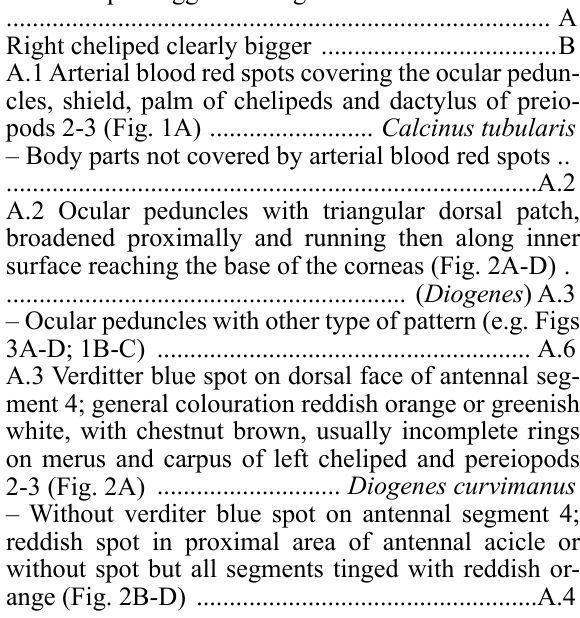
Eyes (Fig. 14C.1). Velvet black reduced corneas; ocular peduncles peach blossom red. Antennules (Fig. 14C.2) hyaline Berlin blue with wood brown ring on proximal margin of segments 2-3. Antennae (Fig. 14C.3) peach blossom red with some darker areas. Shield (Fig. 14C.4) deep peach blossom red, darker on frontal margin. Chelipeds. Right (Fig. 14C.5-6) with rose red background fading distally, and scattered wood brown stains. Left (Fig. 14C.7-8) similar to right, but generally whiter with palm usually snow-white. Pereiopods 2-3 (Fig. 14C.9-10) peach blossom red, more intense on ischium and merus, fading towards dactylus; distal half of propodus and entire dactylus almost